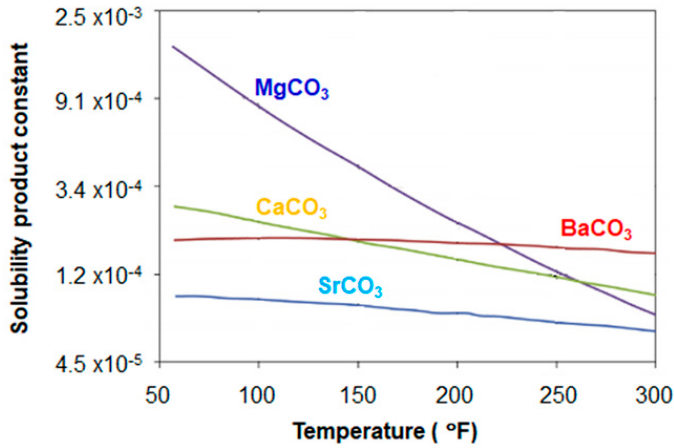
Figure 2. Solubility of carbonate scale.4. Mechanism of Scale Inhibitions